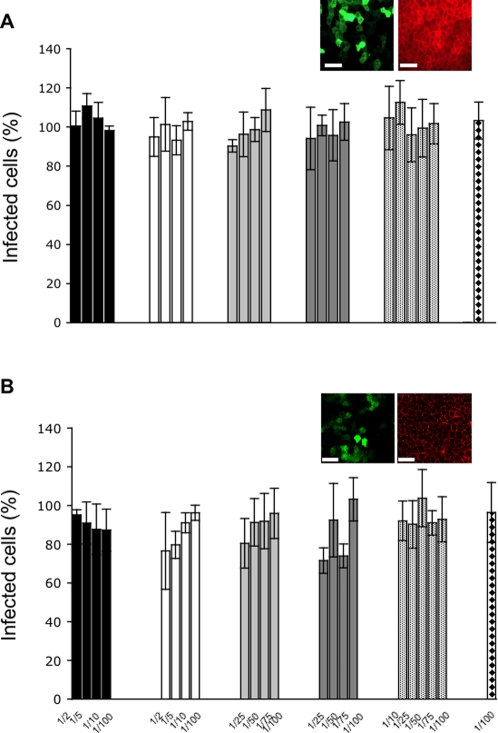
Effect of surfactants on adenoviral and lentiviral infections.Polarized MDCK cells grown on cover slips or polycarbonate filters were exposed to the adenovirus or lentivirus after the addition of the surfactants for about 1 h after which the cells were washed and placed in a fresh detergent- and virus-free culture medium. Infectivity was assessed 16–18 h or 48 h after virus and surfactant removal. A, MDCK infected with adenovirus expressing the GFP-GL-GPI. B, MDCK infected with lentivirus expressing GFP. The efficiency of infection was assessed by counting the number of infected cells (green cells, insert pictures) relatively to the total number of cells (given by staining the cells with rhodamine-phalloidin that labels the actin-cytoskeleton (red cells, insert pictures). Triton X-100, black columns. DDPS, empty columns. C10TAB, light grey columns. C12TAB, dark grey columns. C14TAB, columns filled with dots. SDS, columns filled with diamonds. Concentrations of the surfactants relative to their respective CMC are indicated at the graph abcissa of B. Infectivity is expressed as a percentage relative to cells infected in the absence of surfactant. Results are shown as mean values±standard deviations of 3–4 independent experiments in which each concentration was tested in duplicate.